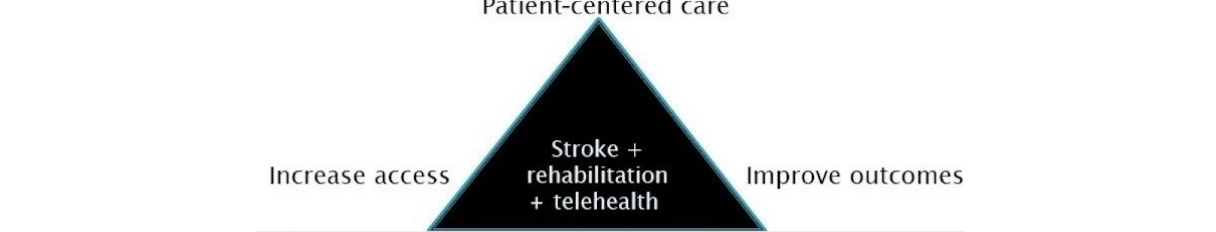
Figure 1. Goals for telerehabilitation for poststroke care.